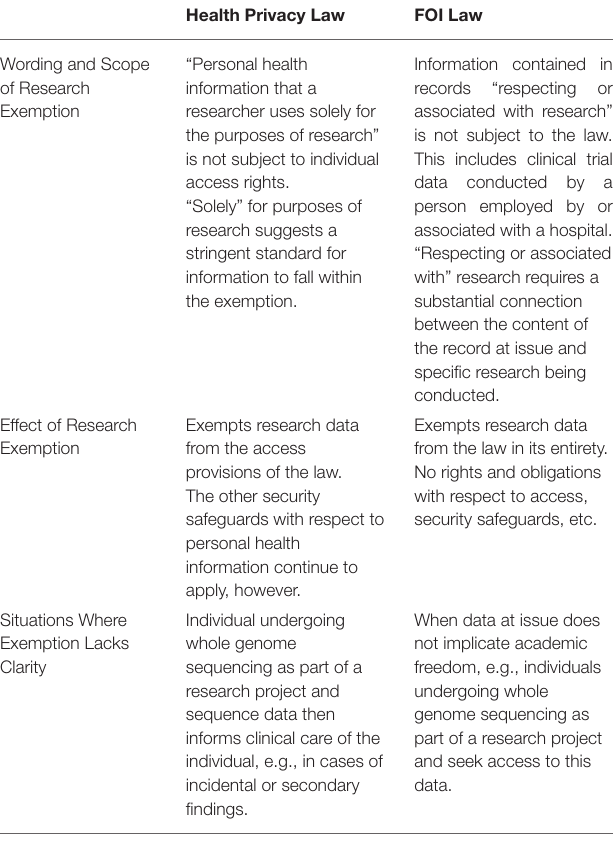
TABLE 2 | Comparison of research exemptions in Ontario’s health privacy and FOI